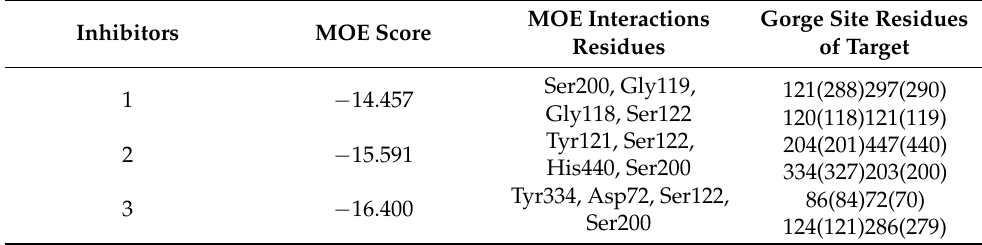
Table 5. Interaction features of Compounds 1 – 3 against